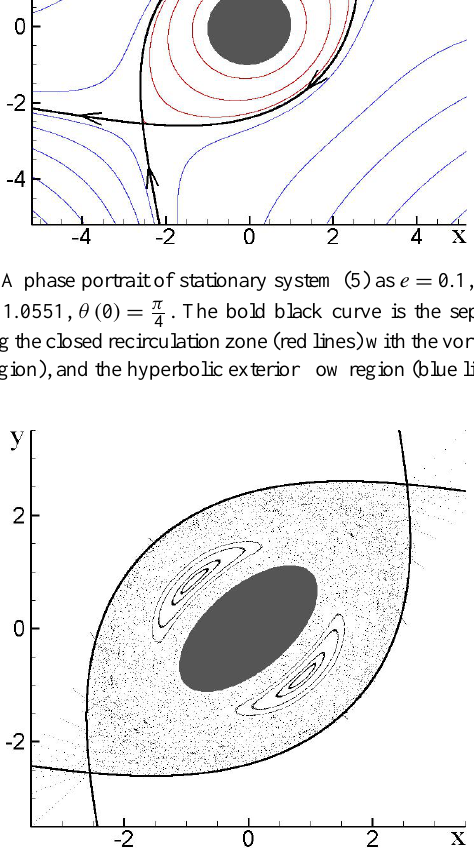
Fig. 2. A Poincar´e section of system (5) as a( 0 ) the parameters corresponding to Fig. 1. The bold black curves are the separatrix of the associated steady